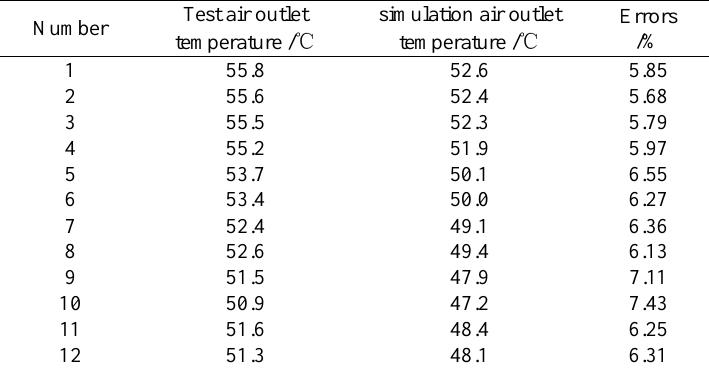
Table 1. Comparison of error between simulation and measured